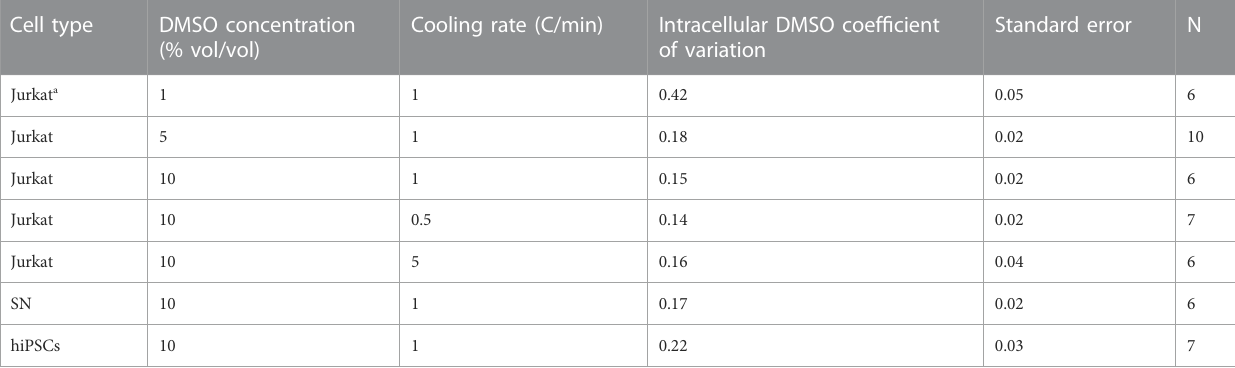
TABLE 2 Coef fi cient of variation of the relative concentration of the Raman signal for DMSO inside of the cellular space for each cell type and condition. Cell type DMSO concentration Cooling rate (C/min) Intracellular DMSO coef fi cient Standard error (% vol/vol) of variation